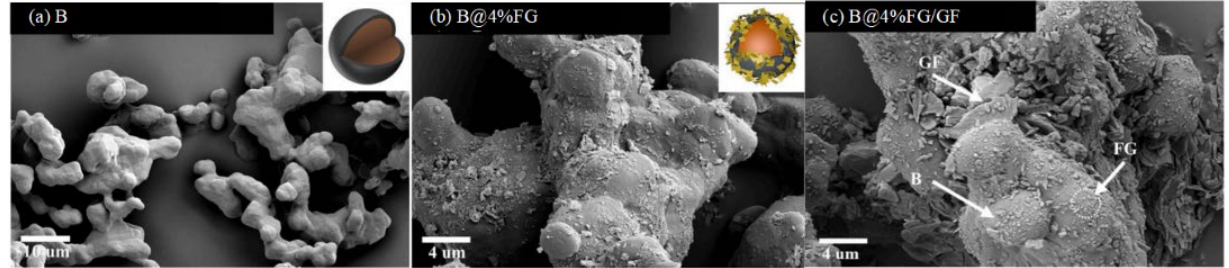
Figure 11. SEM images of ( a ) raw boron; ( b ) B@4%FG; and ( c ) B@4%FG/GF [95].